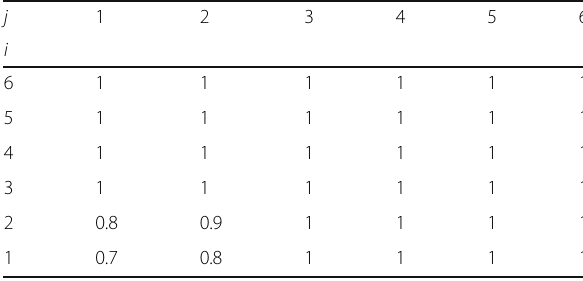
Fig. 29 The maximum energy consumption at optimal duty cycle under UDNP and EDNP (MQAM)